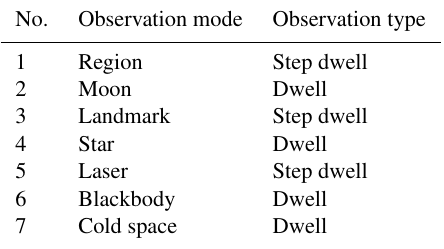
Table 5. Observation modes of GIIRS.